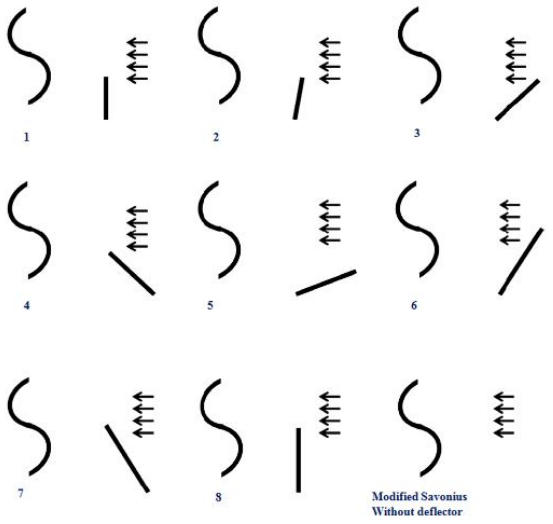
Figure 7. Various installation angles and positions of flat-plate deflectors (adapted from